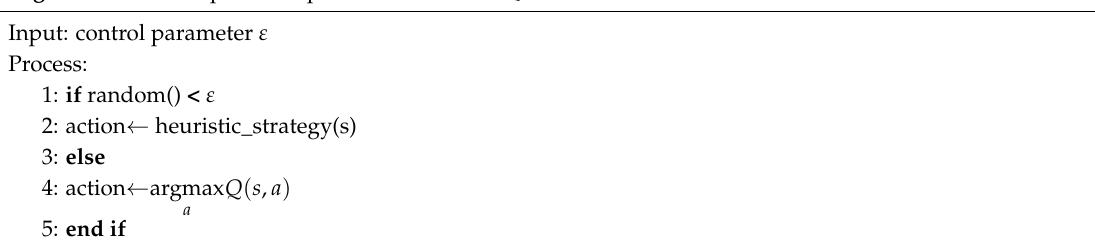
Algorithm 2. The exploration process of heuristic